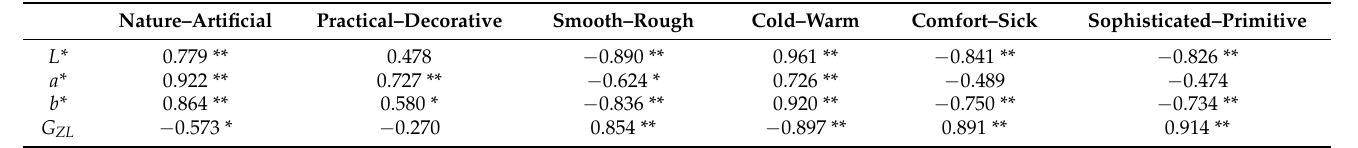
Table 8. Correlation analysis between physical and psychological